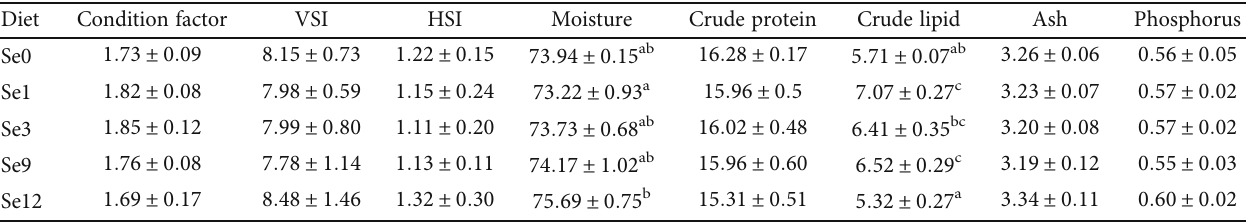
Table 3: Condition factor (g/cm 3 ), visceral somatic index (VSI, %), hepatosomatic index (HSI,%), and proximate composition (%) of juvenile triangular bream ( Megalobrama terminalis ) fed the test diets for 8 weeks. Diet Condition factor VSI